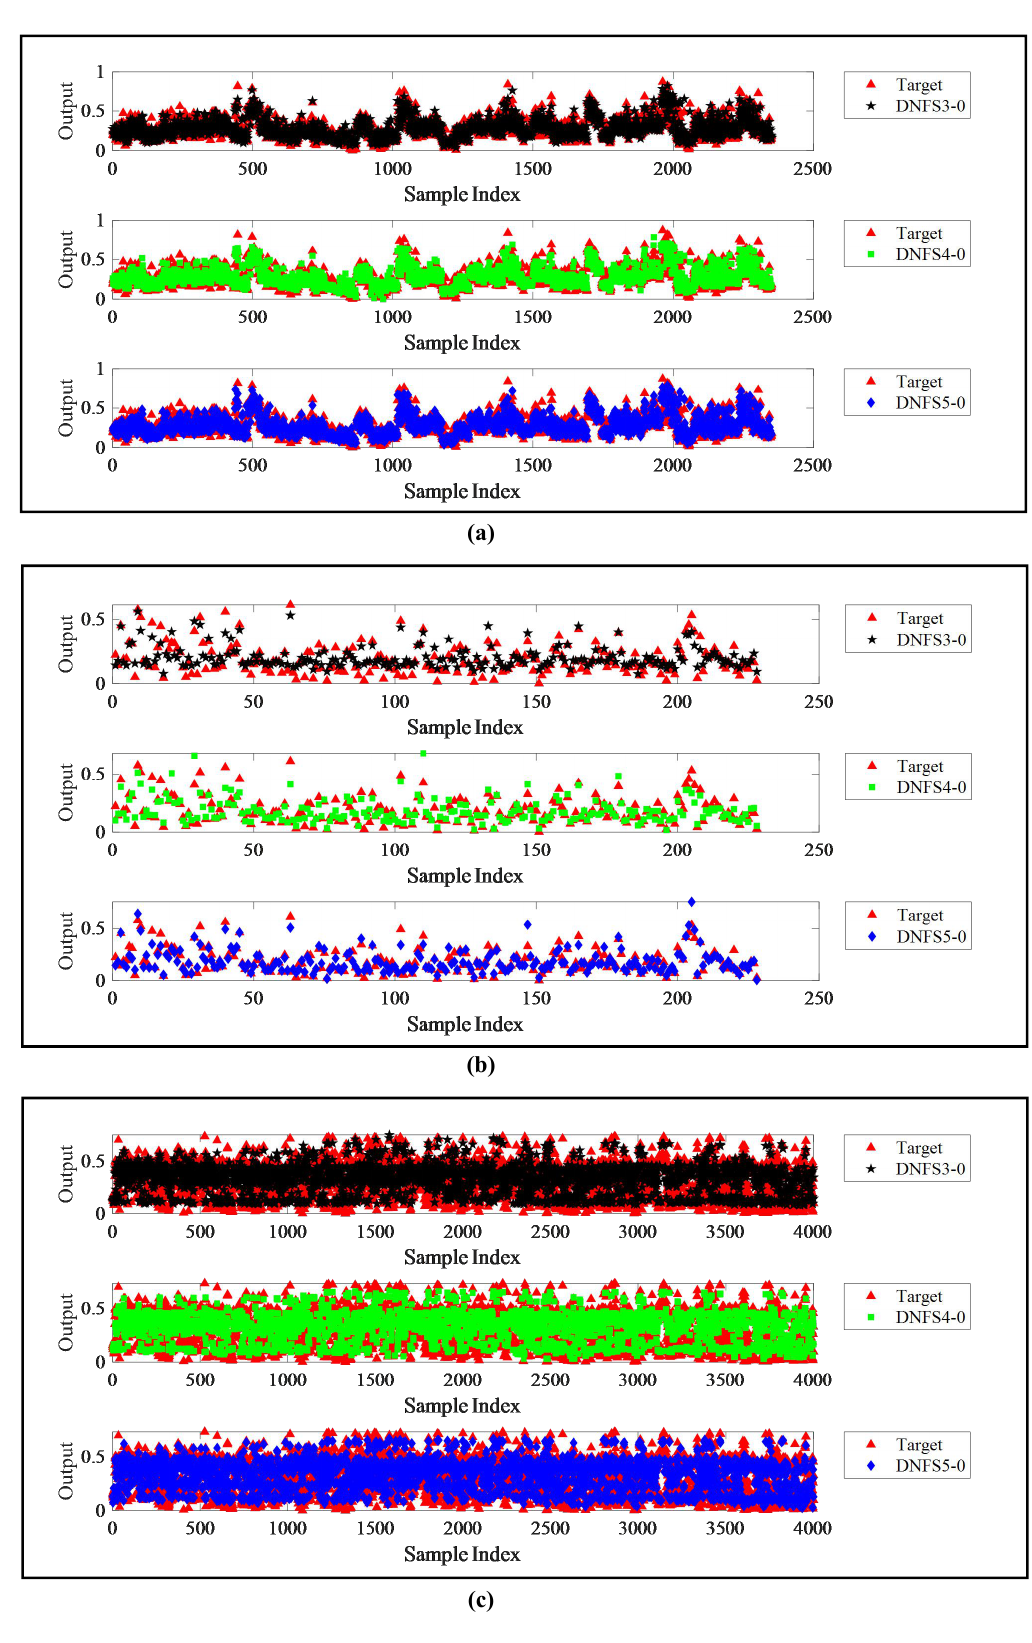
Figure 3. Prediction chart of DNFSs with different submodule inputs on the three test datasets. ( a ) Test Dataset No. 1. ( b ) Test Dataset No. 2. ( c ) Test Dataset No.